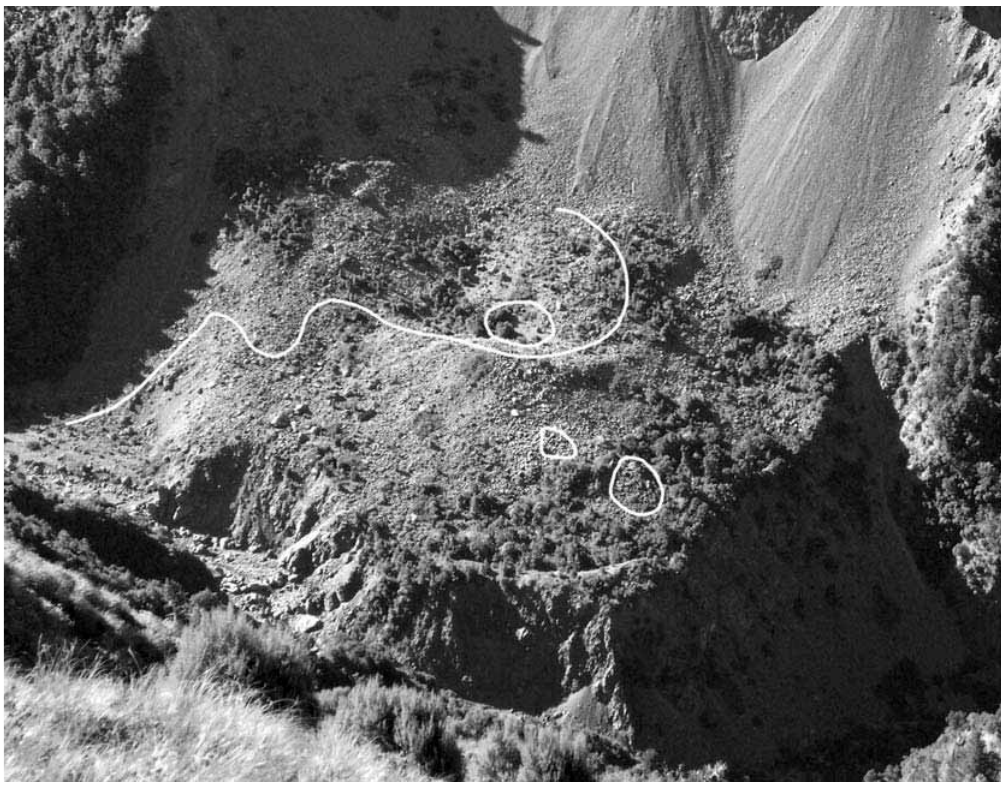
Fig. 4. View of Barretts landslide complex from Mount Stace. Unstable headscarp is partially buried with talus cones. The Hapuku River has removed portions of the toe of the landslide, thus creating younger landslides. Line shows reconnaissance route. Most lichen-size measurements were made in the enclosed areas. Barretts landslide is 18 km north of the town of Kaikoura in the Seaward Kaikoura Range (figs. 1 and